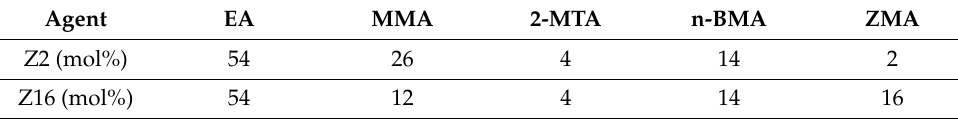
Figure 1. Chemical structures of the organic compounds in the SPC: ( a ) EA, ( b ) MMA, ( c ) 2-MTA, ( d ) n-BMA, and ( e ) ZMA. Table 1. Proportions of various of antifouling agents in the SPCs in this